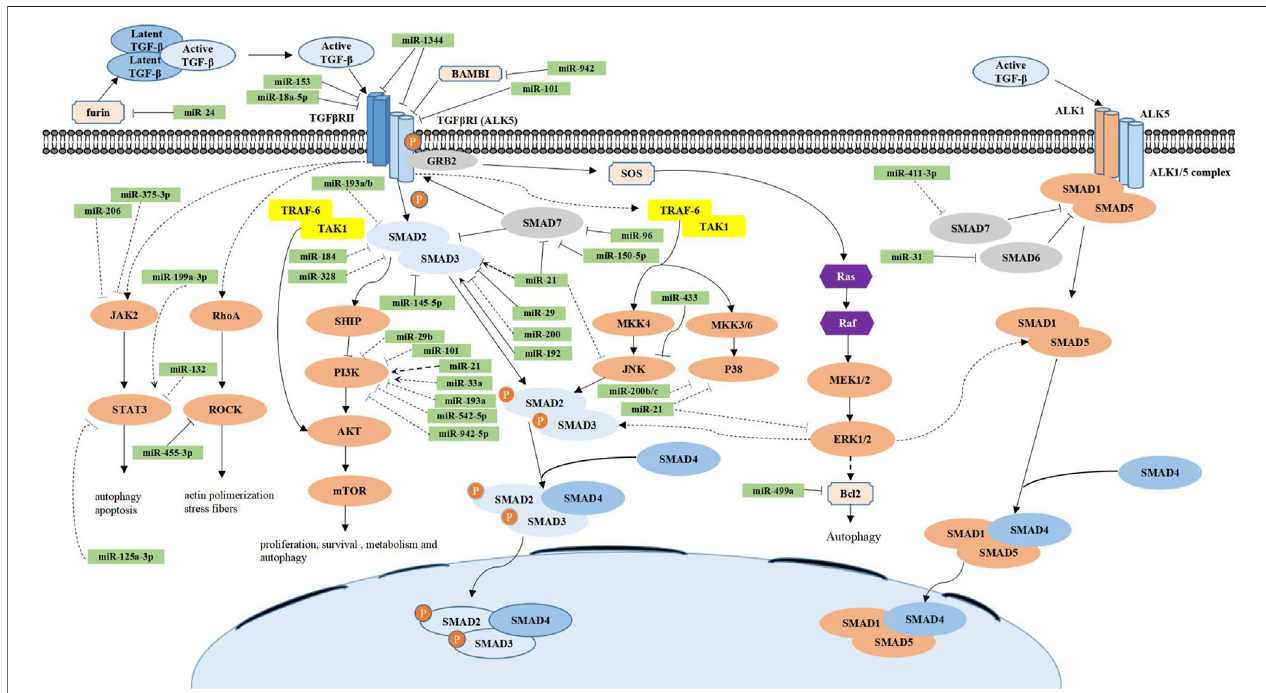
FIGURE 1 | Regulatory mechanisms of miRNAs in the canonical and noncanonical TGF- β signaling pathways. In the canonical TGF- β signaling pathway (blue), active TGF- β is fi rst isolated from the latent TGF- β complex in the extracellular space and then binds to the TGF- β type II receptor (TGF- β RII), which in turn binds and phosphorylates TGF- β type I receptor (ALK5), causing its activation. ALK5 continues to phosphorylate intracellular SMAD-2 and SMAD-3 proteins, which constitute a complex with SMAD-4 and fi nally accumulate in the nucleus and further regulate fi brosis-related gene expression. In addition, the inhibitory function of SMAD-7 competes withSMAD 2/3 tobind with phosphorylated ALK5, thereby inhibiting theTGF- β signaling pathway. The noncanonical TGF- β signaling pathway (orange) most commonly includes the TGF- β /Smad1/5, TGF- β /PI3K/AKT/mTOR, TGF- β /MAPK (ERKs, JNKs, and p38), TGF- β /JAK2/STAT3, and TGF- β /RhoA/ROCK signaling pathways. Their functions are also listed in the fi gure. Numerous miRs have been implicated in the regulation of the canonical and noncanonical TGF- β signaling pathways. miRs are grouped to have the direct (solid line) or indirect (dotted line) effect as well as the promotion (arrowhead) or inhibition ( fl athead)